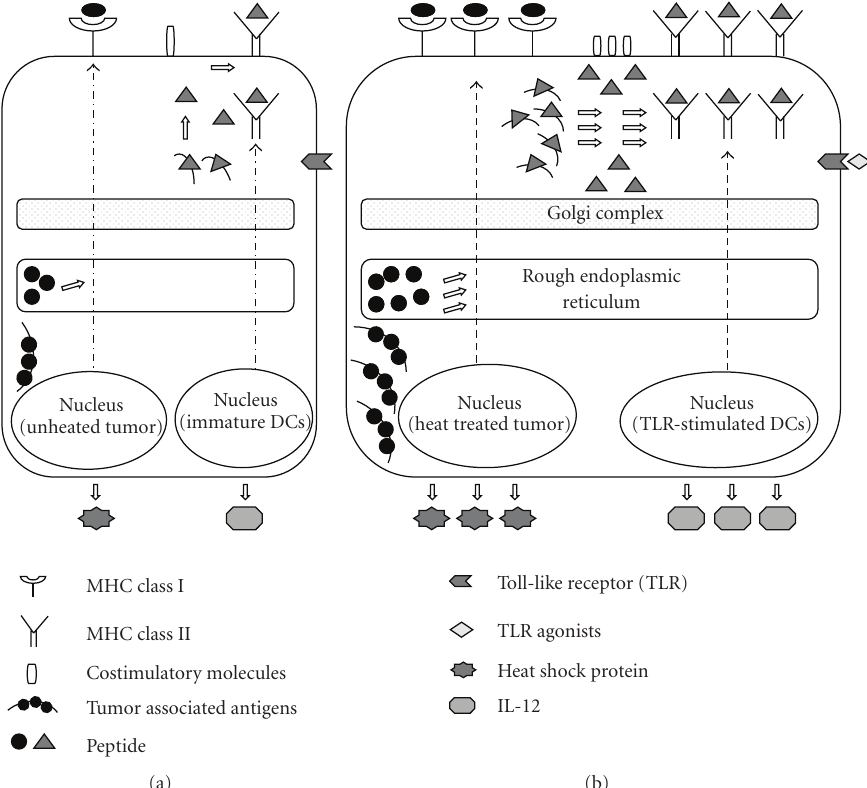
Figure 2: Modified DCs/tumor fusions. (a) Conventional fusions generated with immature DCs and unheated tumor cells express MHC class I and II, costimulatory molecules (CD80 and CD86), Toll-like receptor (TLR), and multiple tumor-associated antigens (TAAs). (b) Fusions generated by fusing TLR-stimulated DCs and heat-stressed tumor cells have characteristic phenotype with upregulation of multiple HSPs, MHC class I and II, costimulatory molecules (CD80 and CD86), maturation marker CD83, multiple TAAs, and IL-12. As compared with conventional fusions (a), synergism between TLR-stimulated DCs and heat-stressed tumor cells enhances the immunogenicity of DCs/tumor